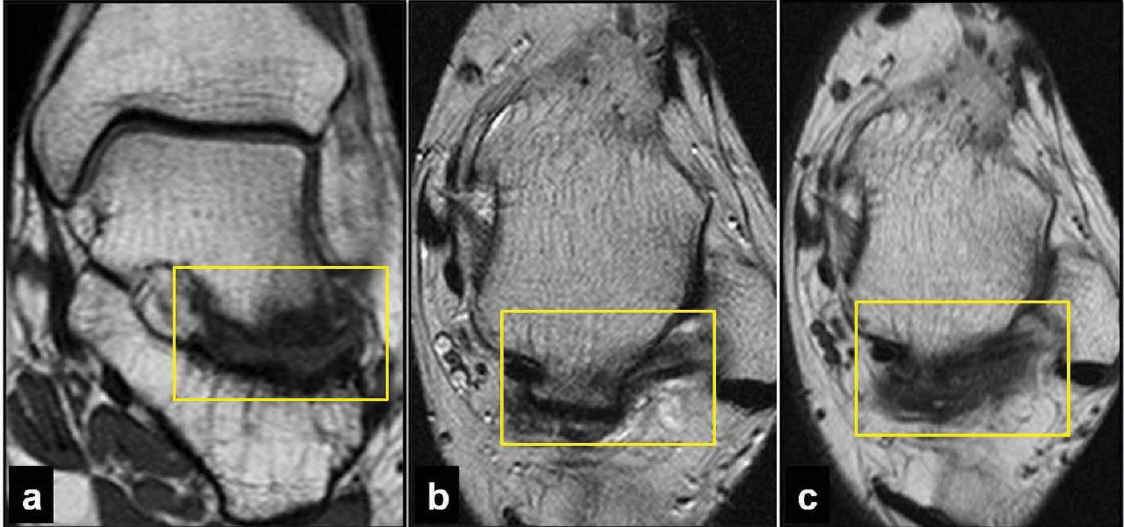
Figure 4. Coronal T1-w (a), axial T2-w (b) and axial T1-w (c) MR images, showing the Stieda process of the talus along with marrow edema and surrounding edematous and fibrotic changes in the surrounding fat (areas in